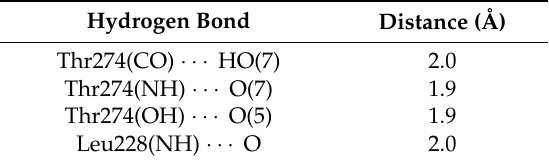
Figure 7. Hydrogen bond interactions of the epothilone B conformer epoB(TUB)_1q5d with amino residues in tubulin dimer. Oxygen, nitrogen, sulfur, and hydrogen are indicated in red, blue, yellow, and white, respectively. Carbon in the drug molecule and tubulin protein are indicated magenta and grey, respectively. Hydrogen bonds are indicated by dotted lines, and their lengths are given. Table 2. Hydrogen bond parameters for the docked epothilone B conformer, epoB(TUB)_1q5d.